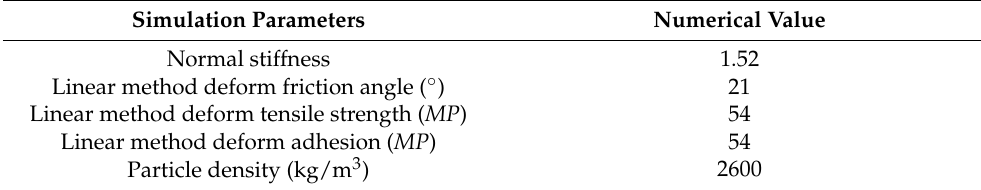
Table 4. Calcareous